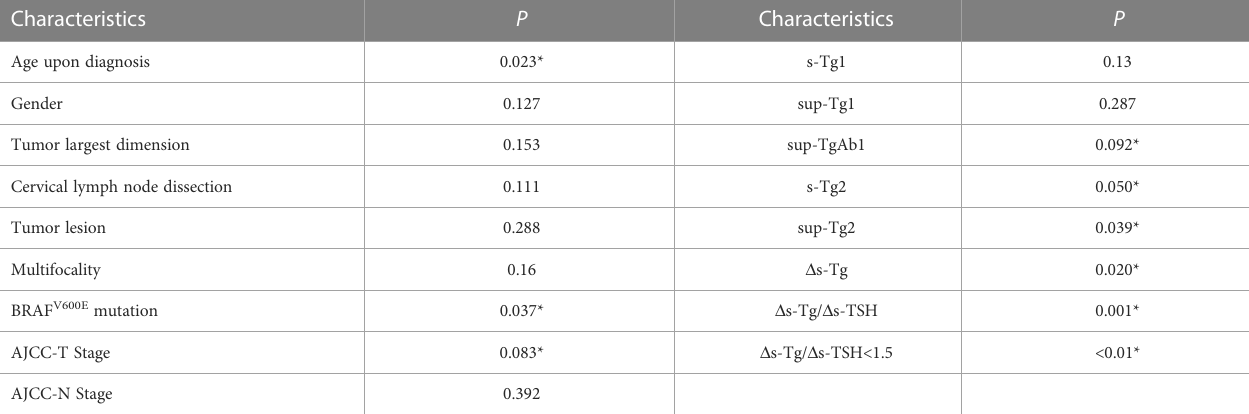
TABLE 2 Results of univariate logistic regression.